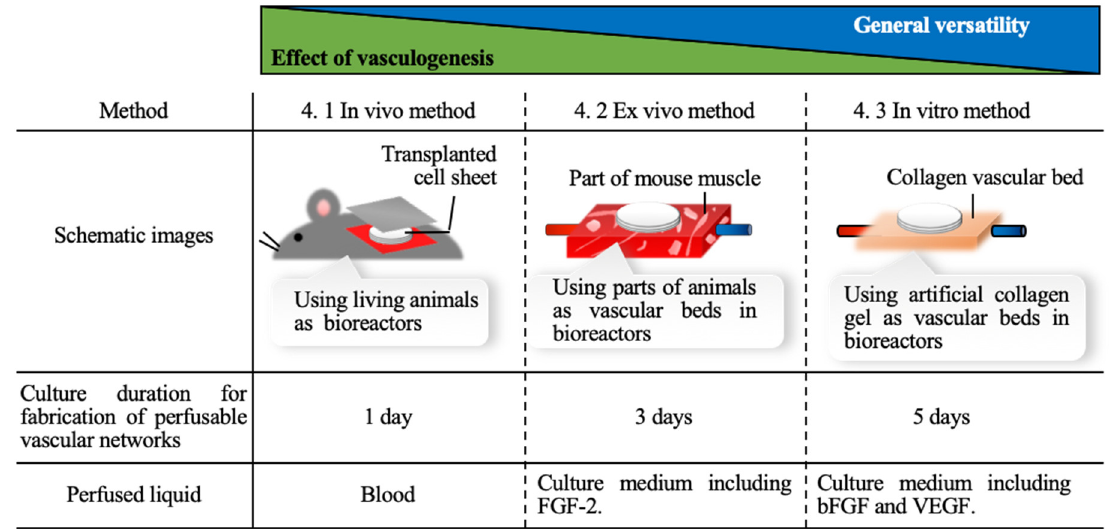
Figure 5. Comparison of each strategy applied for building perfusable vascular network that is described in this review. FGF-2, fibroblast growth factor 2; bFGF, basic fibroblast growth factor; VEGF, vascular endothelial growth factor.